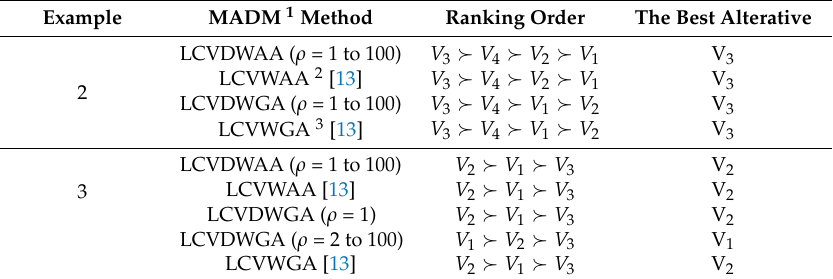
Table 5. Ranking results of different aggregation operators with different